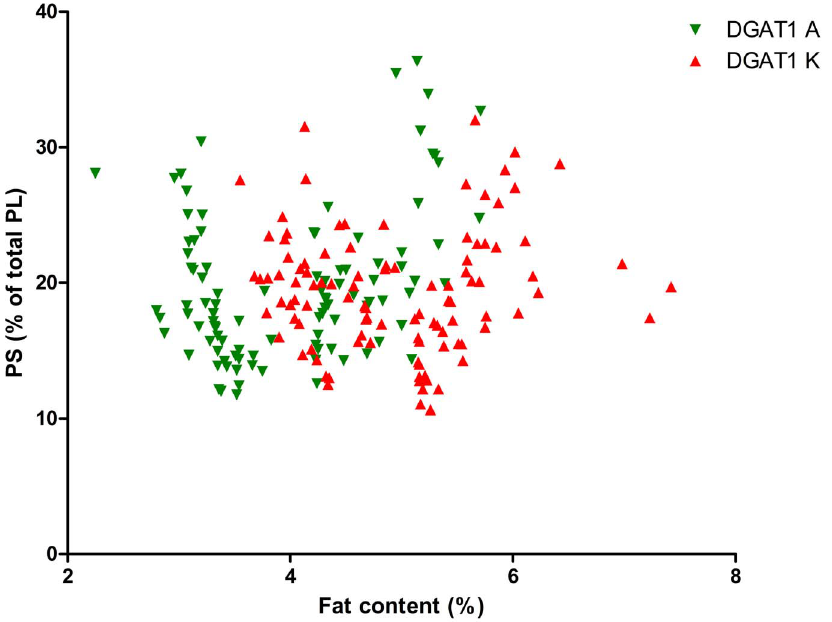
Figure 4. Relationship between fat content (%) and phosphatidylserine (PS) content (% of total phospholipids (PL)) differentiated by DGAT1 genotype.